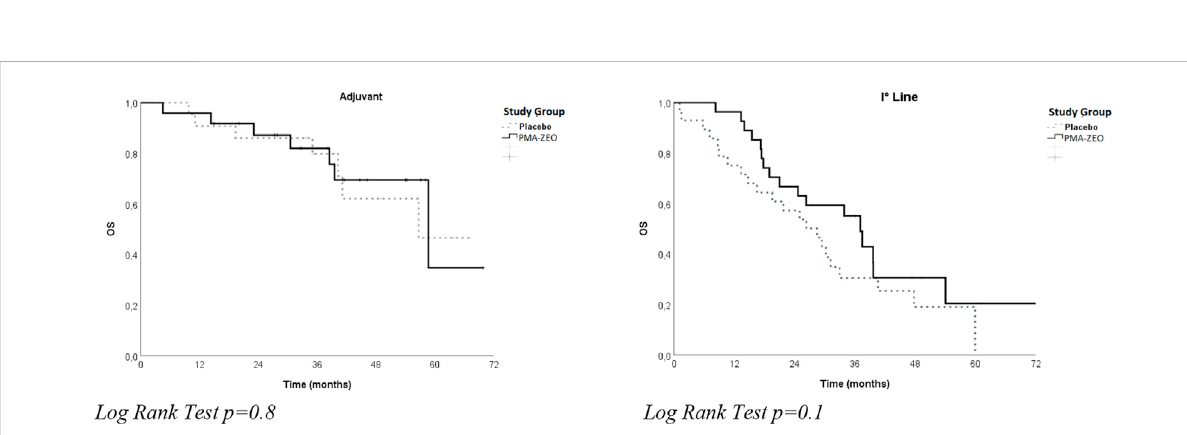
FIGURE 2 Overall survival (OS) for study groups (Placebo vs. PMA-ZEO) strati fi ed by adjuvant and I ° line treatment.